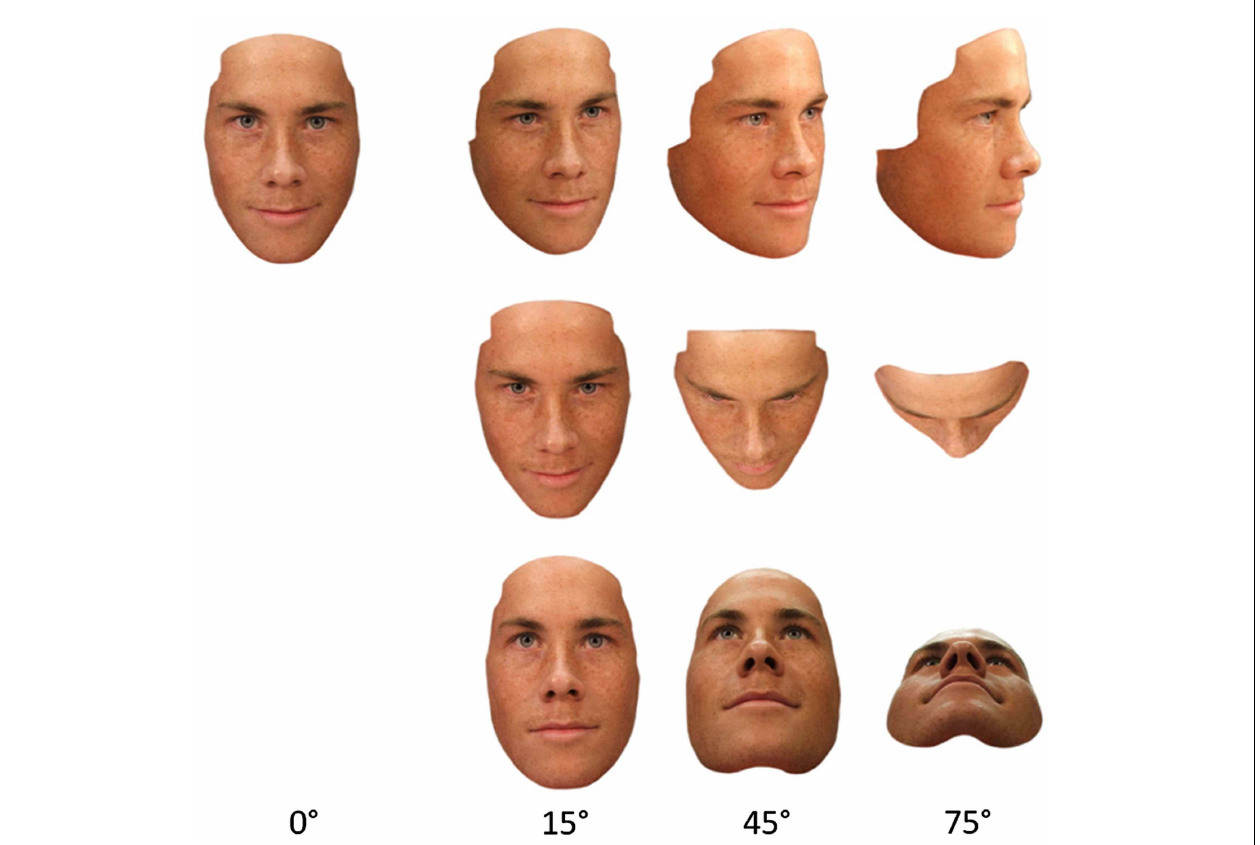
FIGURE 1 | Example of a set of the face stimuli. Views are taken from rotations of 0˚, 15˚, 45˚, and 75˚ in the yaw axis (top row), pitch axis above horizontal (middle row), and pitch axis below horizontal (bottom row).To view the stimuli inverted, rotate the page.